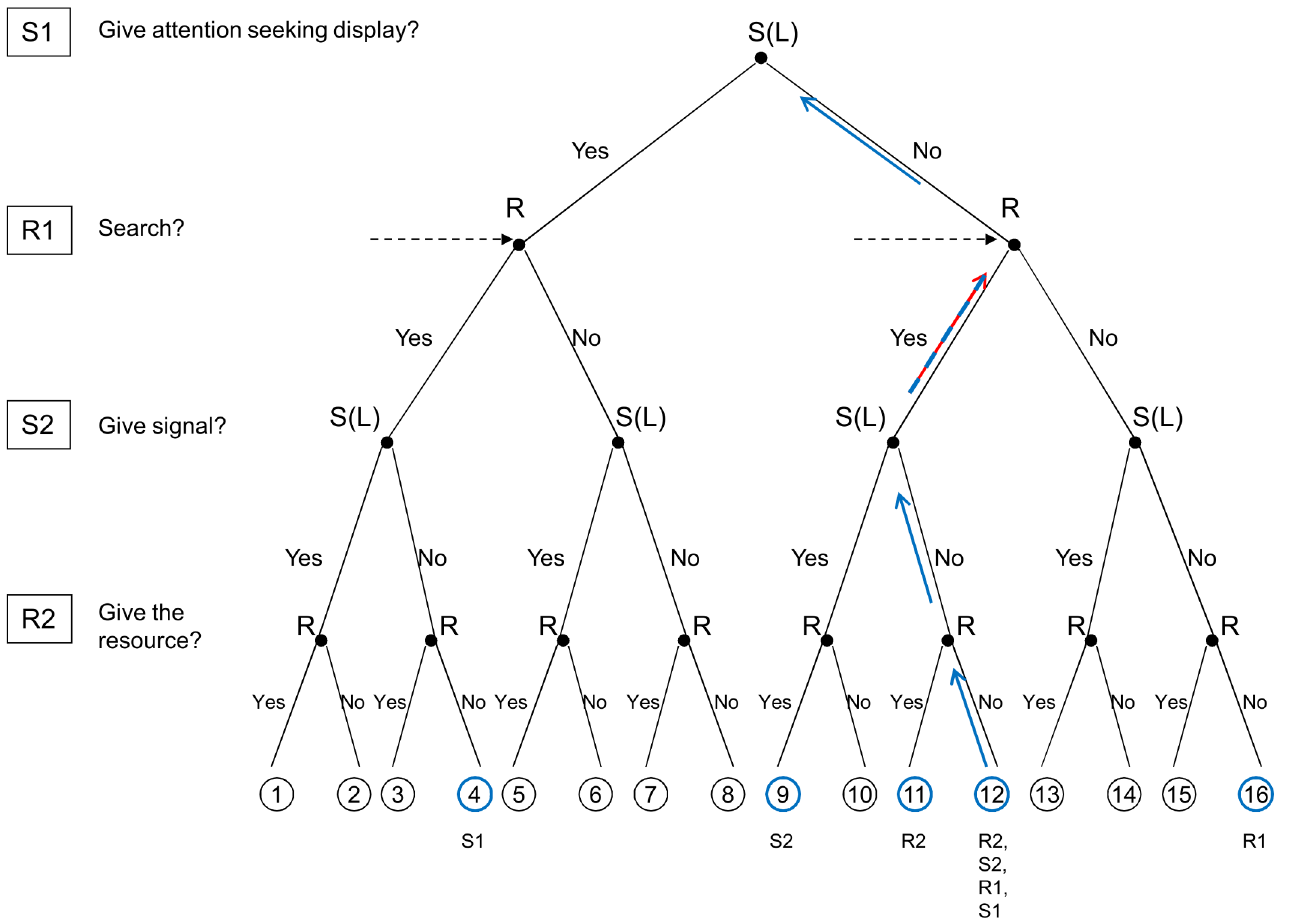
Fig 3. The logic of backward induction for low quality signallers. Arrows show the progression, coloured circles show the compared nodes and the label (s) below the circles show the step at which the given nodes are compared. We are looking for a pair of ESS strategies that lead to node 12 in case of low quality signallers (i.e. where receivers search but they do not give the resource to low quality signallers, and accordingly, low quality signallers do not give signals of quality). First step: node 11 vs. node 12 from the receiver ’ s point of view (R2). Second step: node 9 vs. node 12 from the signaller ’ s point of view (S2; note, since receivers have an (U,D) strategy node 10 is not obtainable). Third step: nodes 1 and 5 vs. nodes 12 and 16 weighted by the ratio of high to low quality individuals from the receiver ’ s point of view (R1; the reason behind comparing several nodes is the informational uncertainty the receiver facing at this point). Fourth step: node 4 vs. node 12 from the signaller ’ s point of view